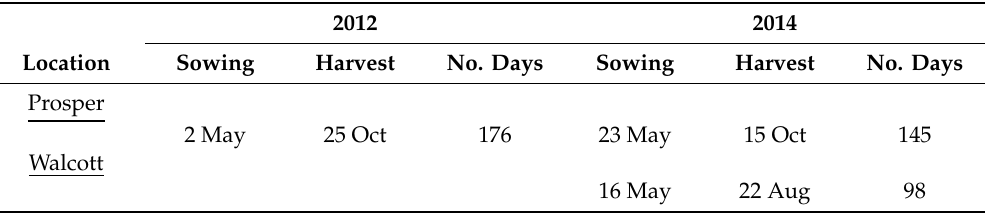
Table 1. Sowing and harvest dates and number of days from sowing to harvest for experiments at Prosper and Walcott, ND, USA, in 2012 and 2014. 2012 2014 Location Sowing Harvest No. Days Sowing Harvest No. Days Prosper 2 May 25 Oct 176 23 May 15 Oct 145 Walcott 16 May 22 Aug